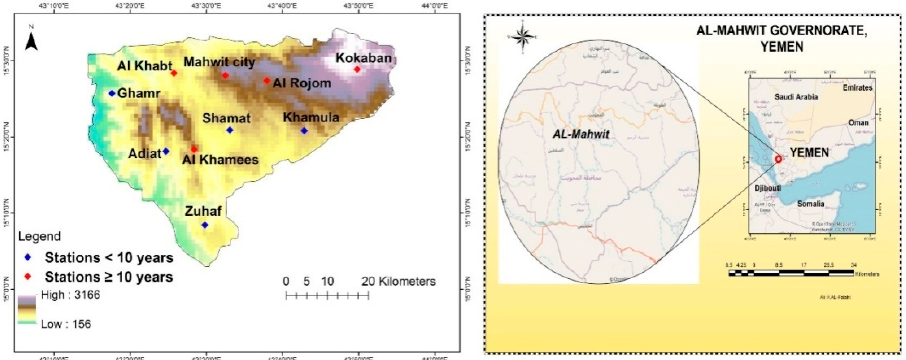
Figure 1. Location of the study area (Al Mahwit) in the Yemeni map displaying topography and the meteorological stations.